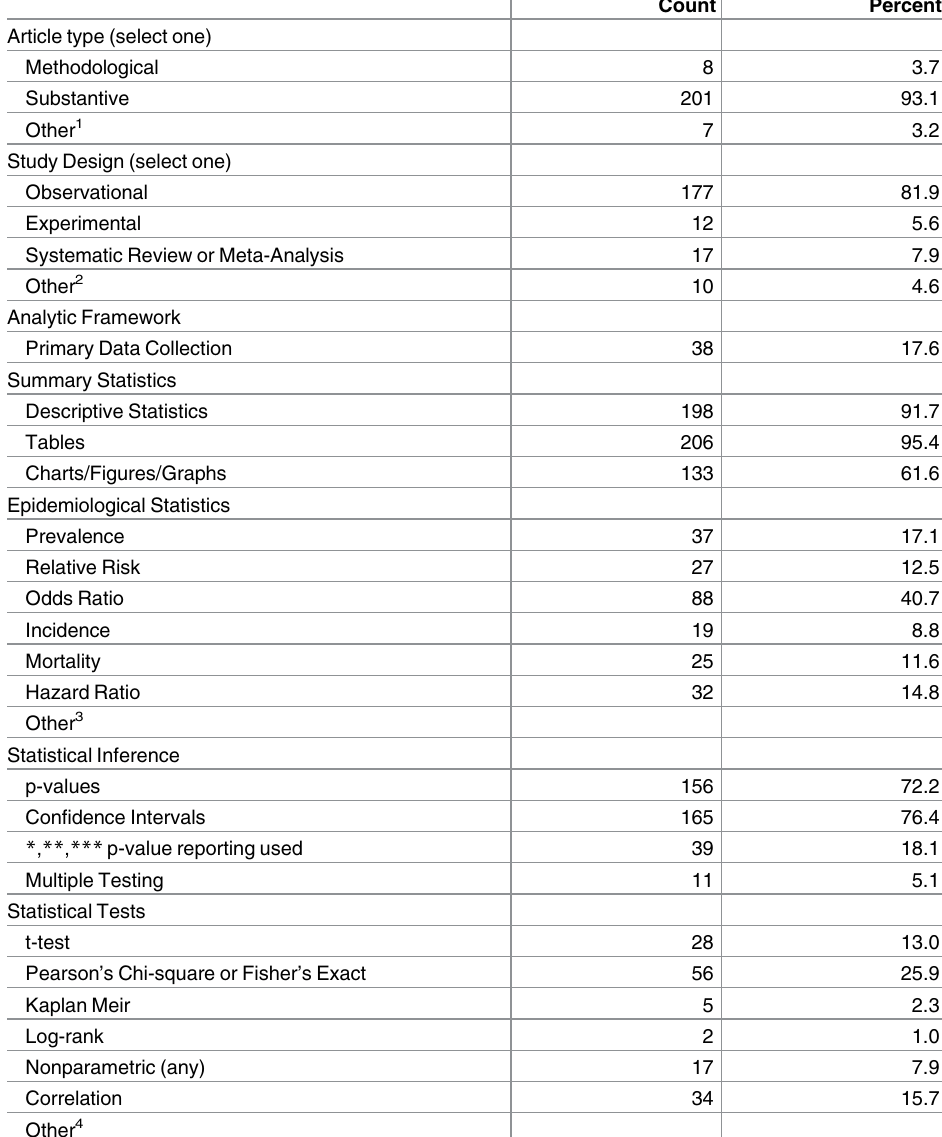
Table 2. Frequency of reported types of studies and use of descriptive and inferential statistics (n =